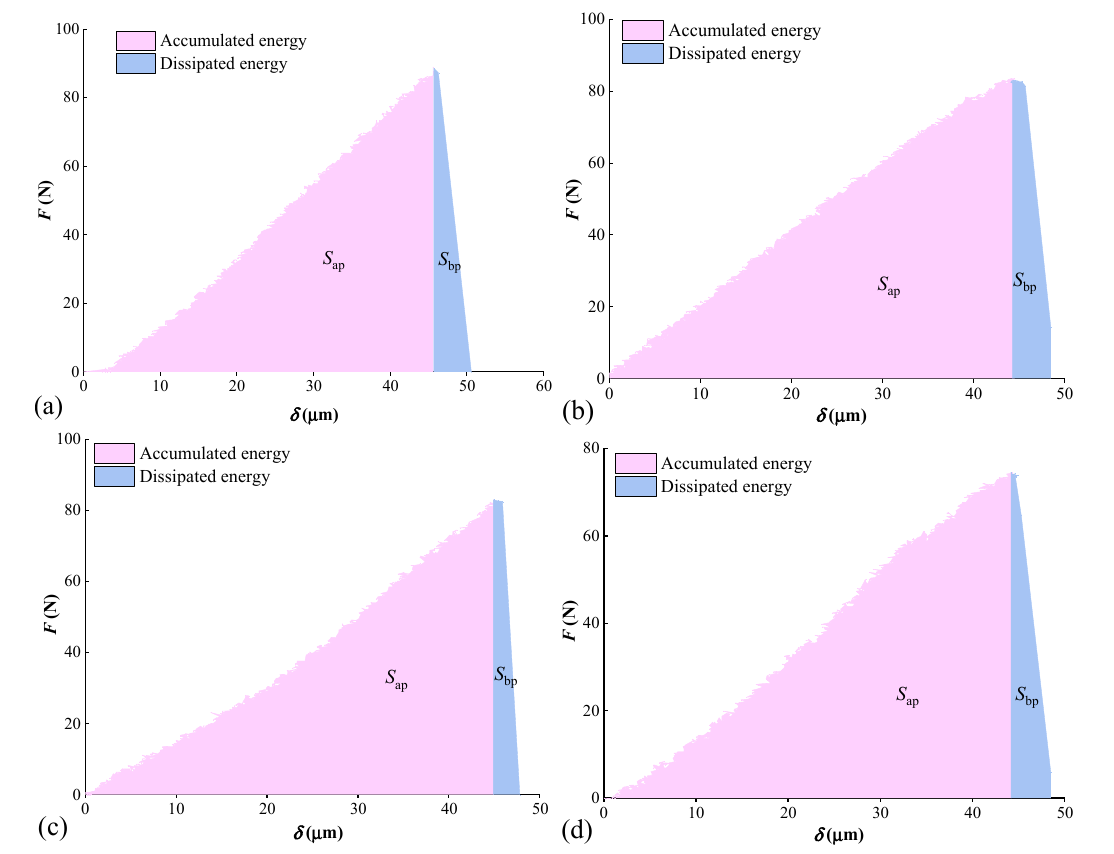
Figure 9. The energy accumulated and dissipated from coal samples: ( a ) XZY-1; ( b ) XZY-2; ( c ) XZY-3; ( d ) XZY-4. ( d ) Table 6. Fracture energy parameters and bending fracture time of the coal samples.